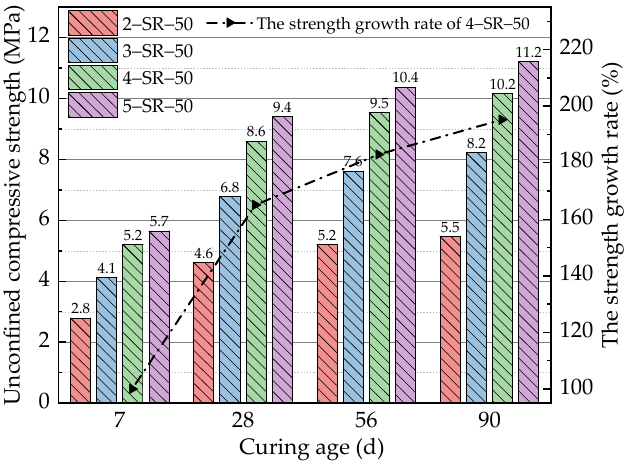
Figure 9. Unconfined compressive strength test results of specimens with different cement con- tents.